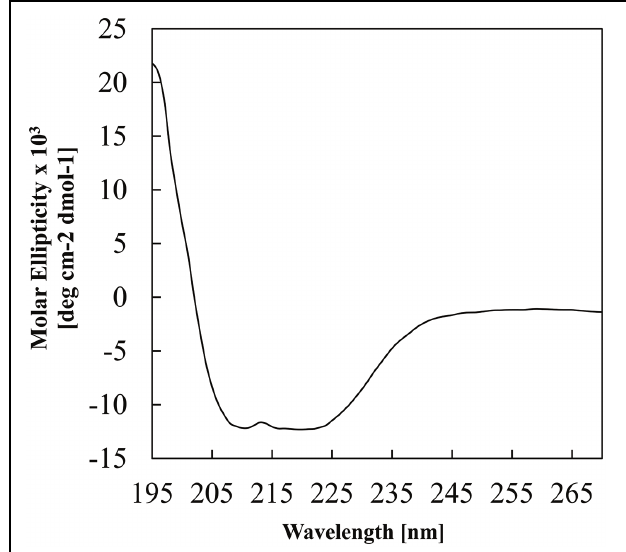
FIGURE 3 | Circular dichroism analysis of purified BC3310-RGSHis 6 protein. The analysis was performed at 1 nm intervals over 270–190 nm with a scan rate of 10 nm min − 1 . The spectrum represents an averaged accumulation of 20 scans, from which the buffer contribution was subtracted.